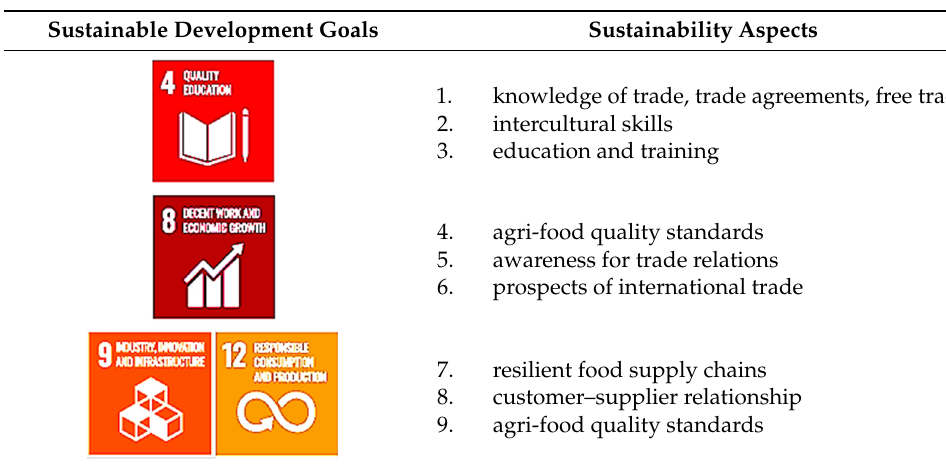
Table 2. Nine defined sustainability aspects (examined on the basis of the SDGs) addressed in the online survey conducted in the EU and US.